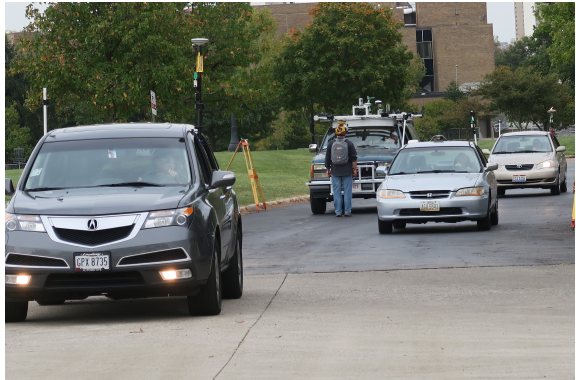
Figure 3. Example 2 of car configuration.